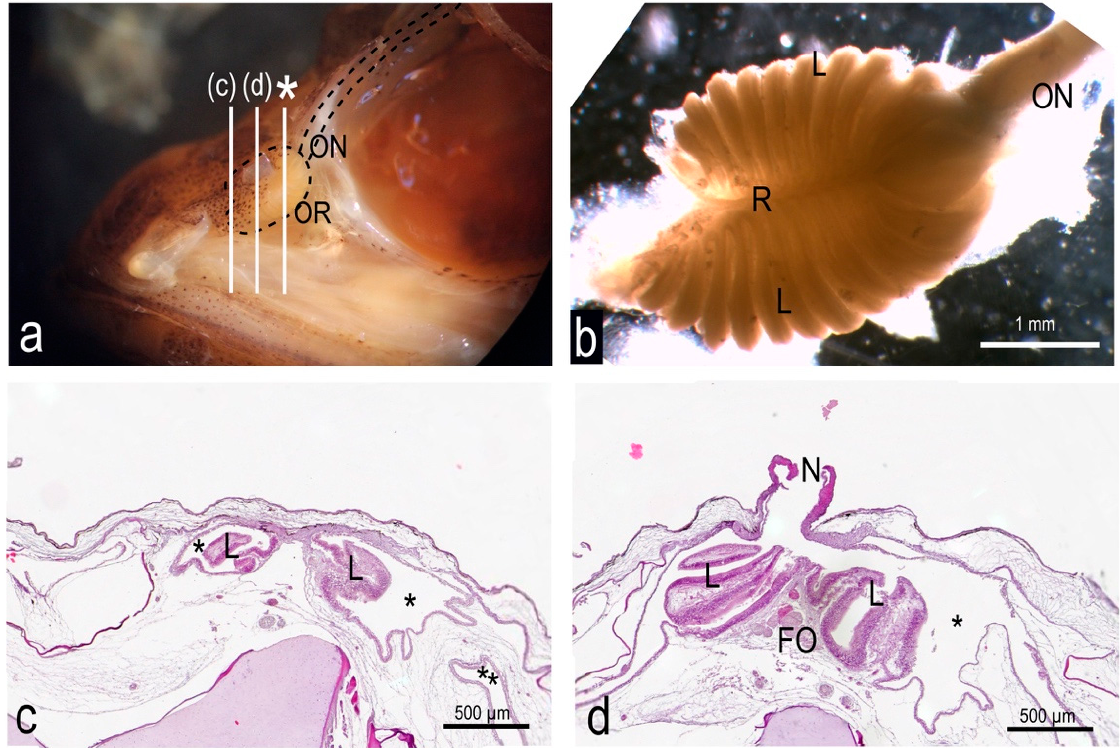
Figure 2. Gross morphology and histology of the olfactory organ of P. antarcticum . ( a ) Partially dissected head with the olfactory rosette visible in place in the olfactory chamber. The three white lines indicate the cutting plane in ( c , d ), and in Figure 3 (asterisk). ( b ) A dissected olfactory rosette showing the two unequal rows of lamellae. Anteriorly, the slightly lacerated tissue where the rosette was attached dorsally to the roof of the nasal chamber is visible. ( c ) Histological section of the olfactory chamber (asterisks) with the olfactory rosette, anterior to the opening of the nostril. The olfactory rosette is fused ventrally to the floor of the chamber and dorsally to its roof. The lamellae are not enveloped in a capsule nor fused with the wall of the olfactory chamber. A branch of the accessory nasal sac is visible in the low-right corner of the picture (double asterisk). ( d ) Histological section of the olfactory chamber with olfactory rosette, at the level of the opening of the nostril. The olfactory rosette is attached only to the floor of the olfactory chamber. FO = fila olfactoria; L = lamellae; N = nostril; ON = olfactory nerve; OR = olfactory rosette; R = raphe.